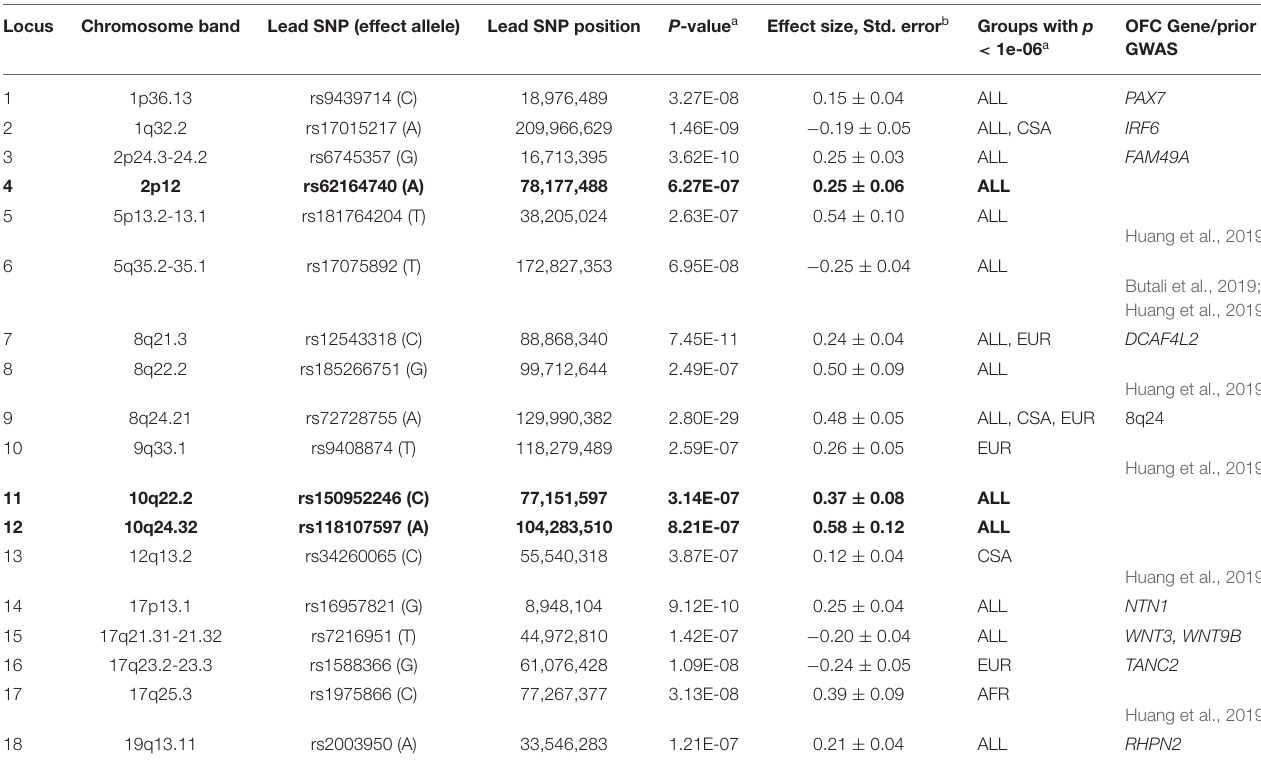
TABLE 2 | Associations with p -values < 1e-06. Locus Chromosome band Lead SNP (effect allele) Lead SNP position P -value a Effect size, Std. error b Groups with p